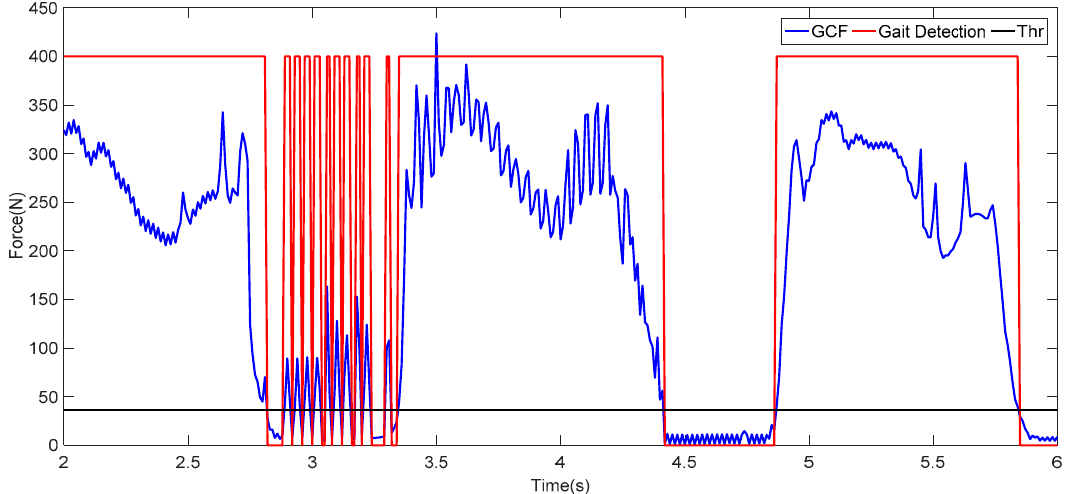
Figure 2. Abnormal values existing in the data collection for ground contact force (GCF). Thr, threshold.